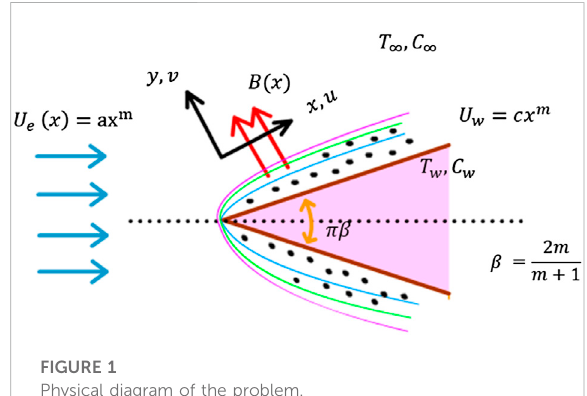
FIGURE 1 Physical diagram of the